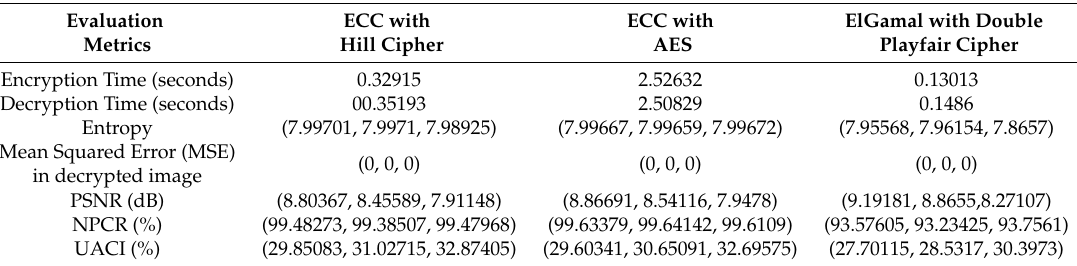
Table 3. Metric measures for Mona Lisa (coloured).